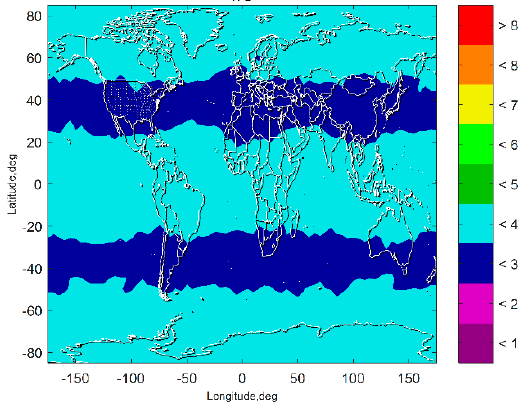
Figure 7. Vertical protection level (VPL) of the subset reduced GNSS alone FD only ARAIM.